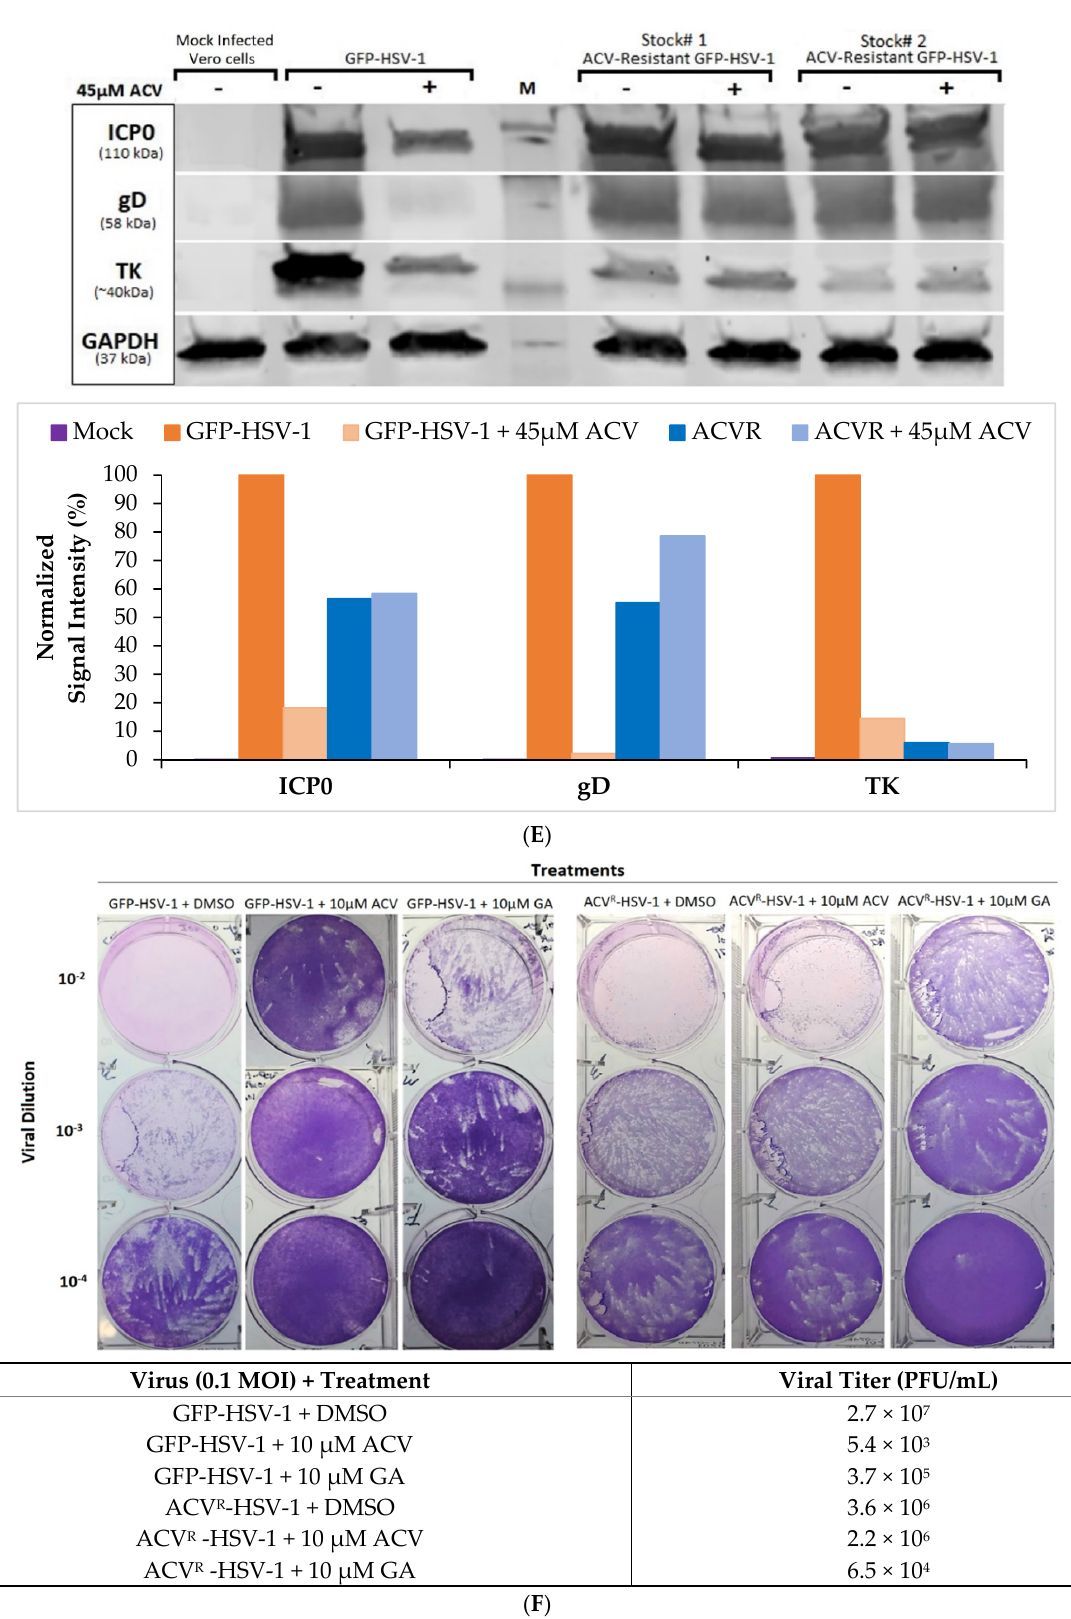
Figure 1. Verification of acyclovir-resistant (ACV R ) HSV-1 infection in Vero cells. ( A ) Flow chart of the methodology used to create ACV-resistant (ACV R ) mutants, adapted from Sarisky et al. [33]. Verification of acyclovir-resistant (ACV R )-GFP-HSV-1 17+ in Vero cells. ( B ) Fluorescent images of 0.1 MOI GFP-HSV-1 infection in Vero cells with or without 45 µ M ACV.